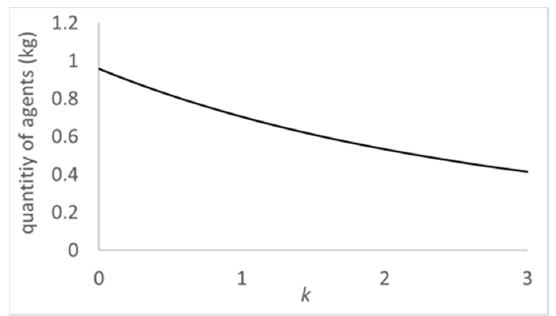
Figure 1. Required quantity of inert gas agents per unit volume vs. k (k = E m /R m ).